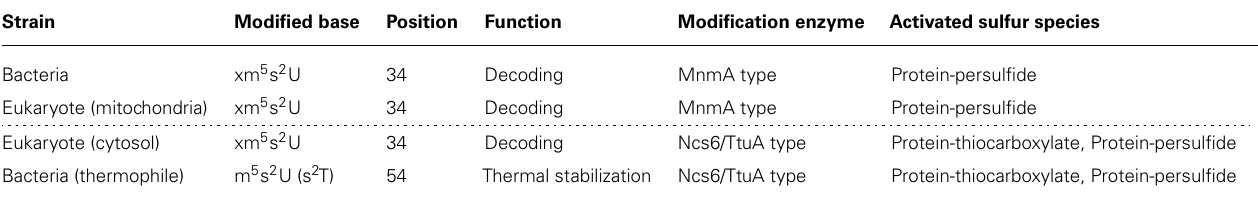
Table 1 |Two pathways of 2-thiouridine